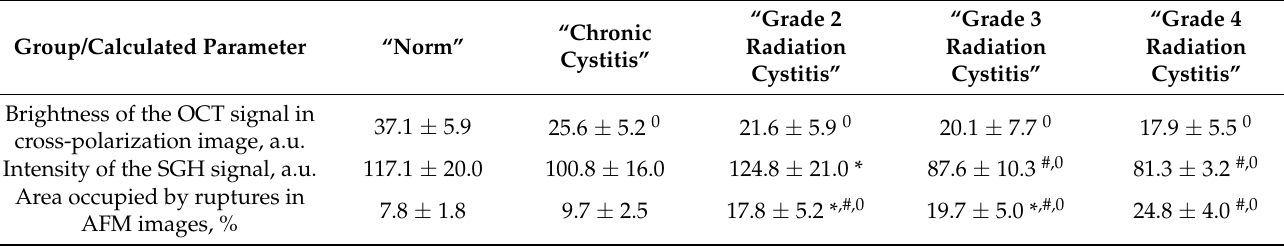
Table 2. Results of the quantitative analysis of CP OCT images, SHG and AFM images reflecting the degree of damage of the bladder